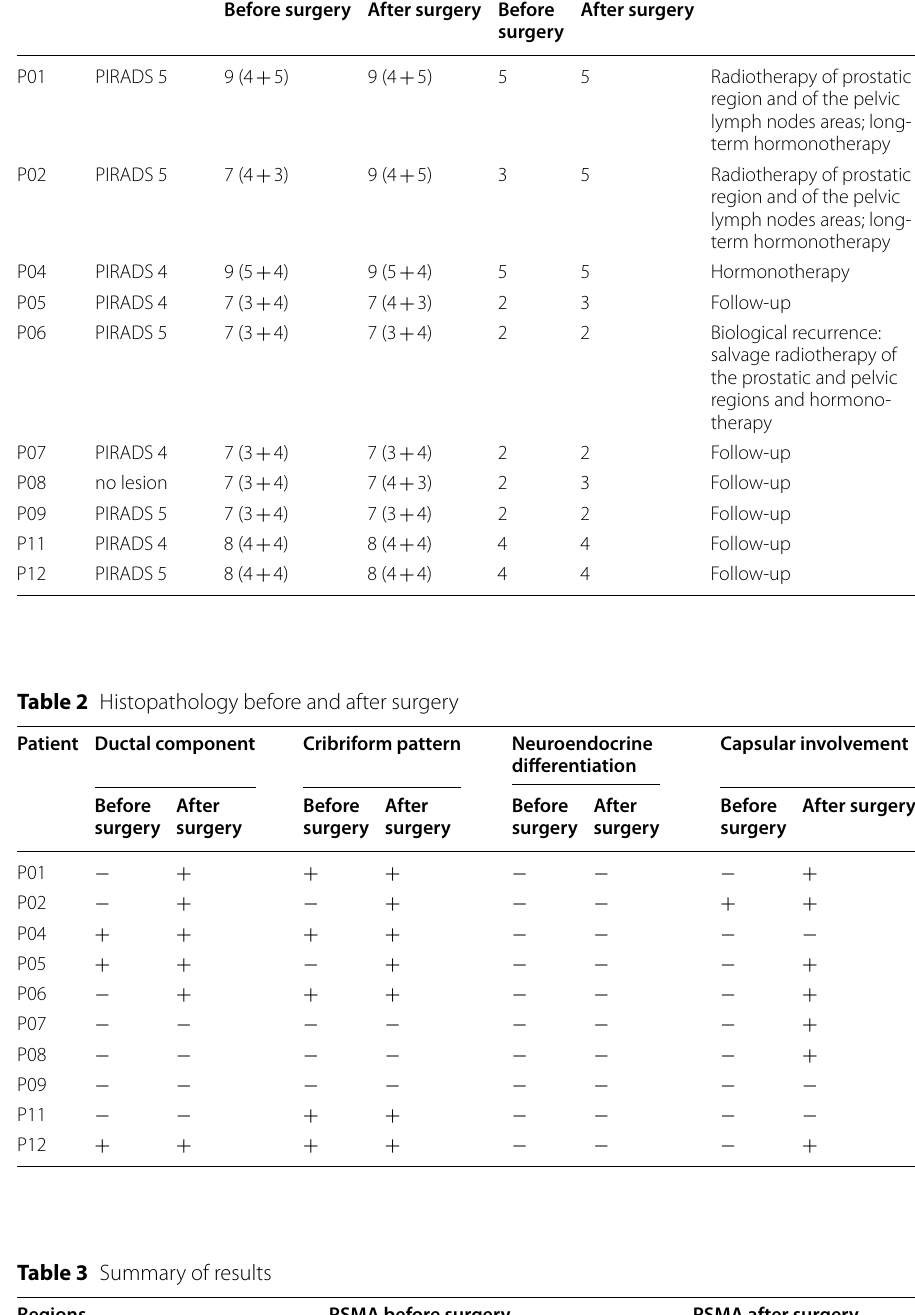
Table 1 PIRADS prostate lesions classification, Gleason scores, ISUP staging and decision after surgery Patient MRI lesion Gleason scores classification